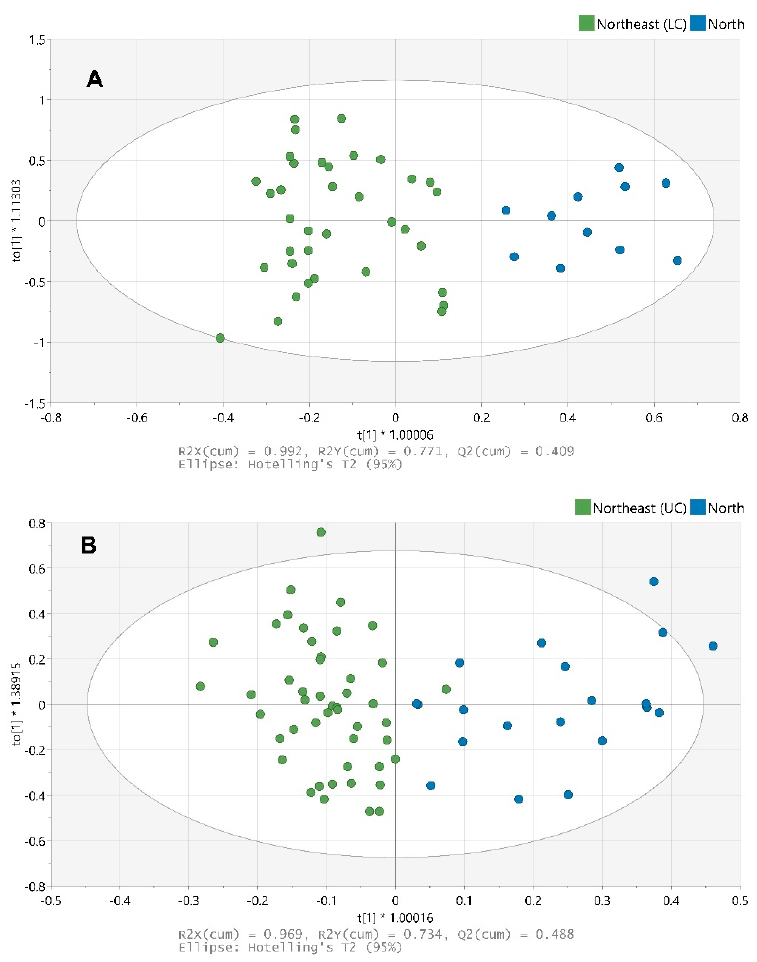
Figure 3. OPLS-DA models of the training dataset analyzed with NIR: year 2018 ( A ) and 2019 ( B ). Table 4. Handheld NIR: goodness of fit and predictive ability of OPLS-DA models for the 2018 and 2019 datasets. N (Train. Year Rice Samples Set)